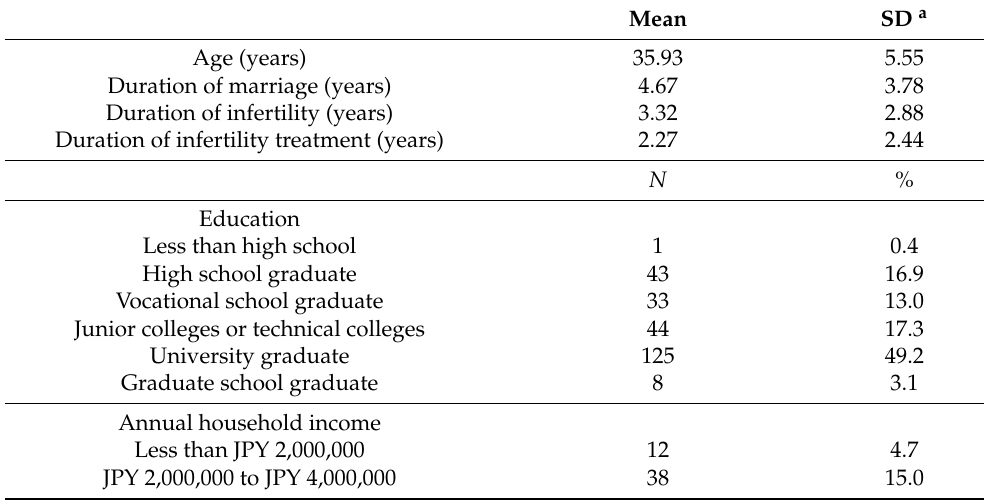
Table 1. Participant characteristics (N =